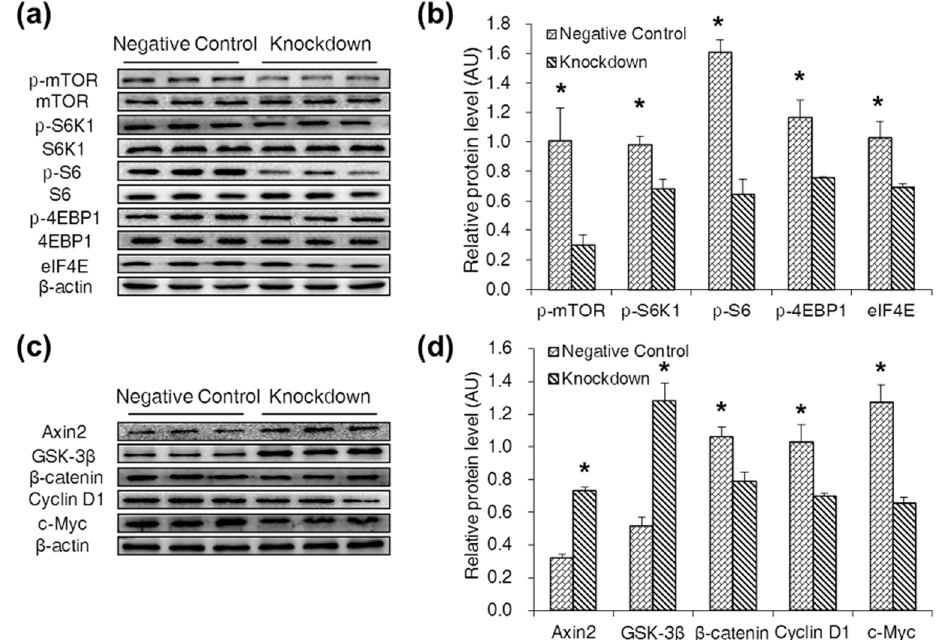
Figure 4. CDX2 knockdown inhibited both the mTORC1 and Wnt/ β -catenin pathways. ( a,b )